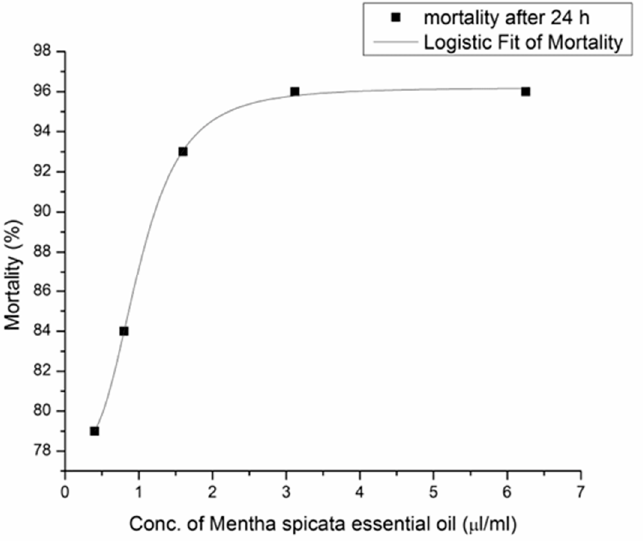
Figure 2. Relationship between mortality (%) and M. piperita EO concentration ( µ L/mL) after 24 h. Mortality after 24 h ( ■ ) and logistic Fit of Mortality (–––).